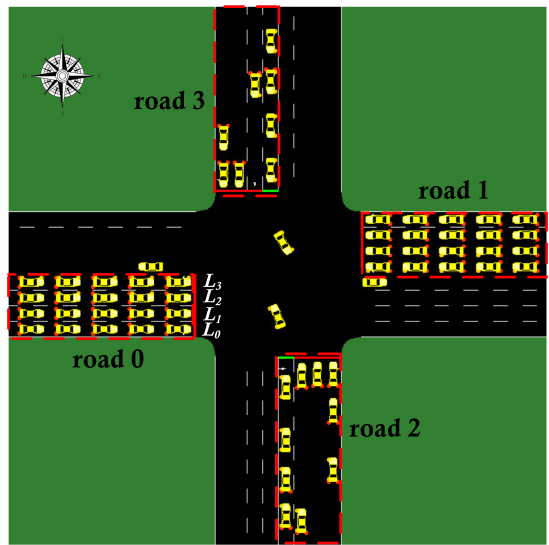
Figure 1. A four-road intersection. The red-dashed region represents incoming road.